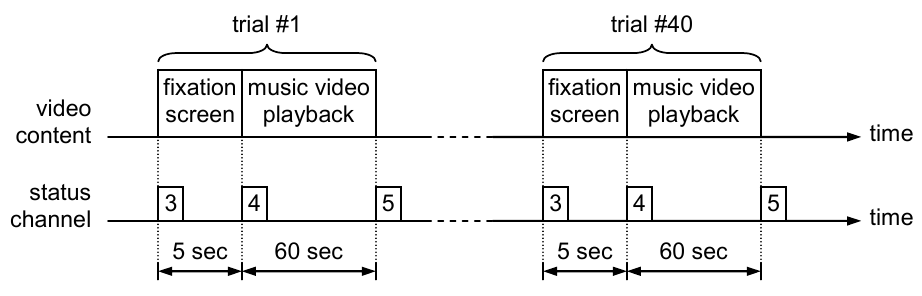
Figure 2. DEAP trial session structure.